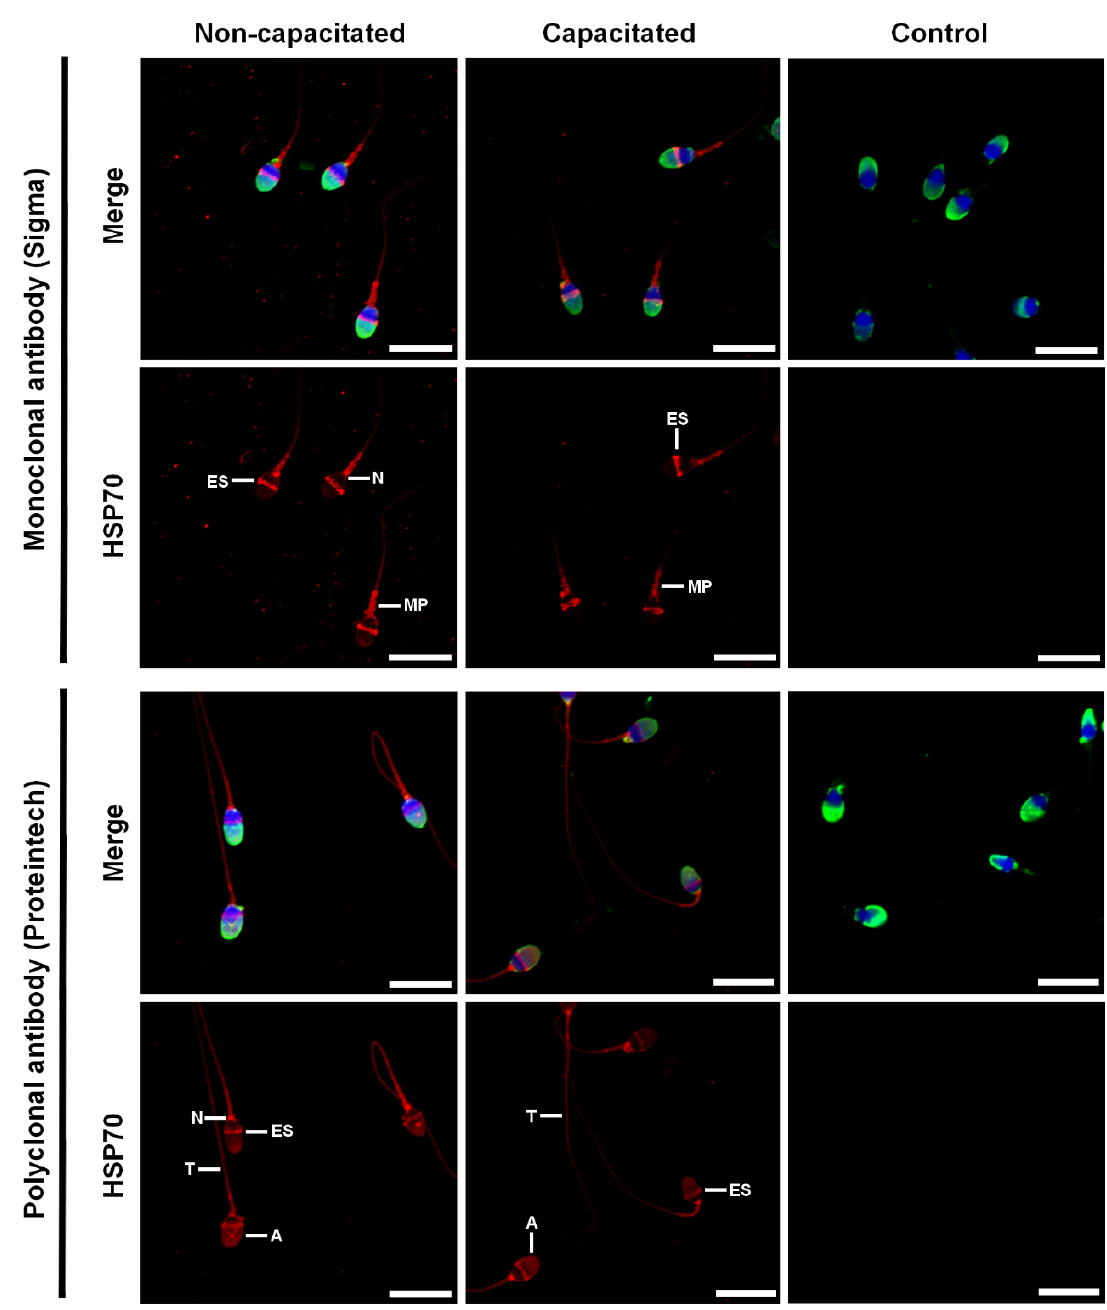
Figure 2. Localization of HSP70 in fixed and permeabilized human spermatozoa. Purified human spermatozoa were incubated or not in a capacitating medium for 4 h. They were then fixed with 4% paraformaldehyde, permeabilized with 0.3% Triton-X-100 and stained with monoclonal (Sigma, H5147) or polyclonal (Proteintech, 10995-1-AP) anti-HSP70 antibodies. Negative controls were performed by incubating non-capacitated spermatozoa without primary antibodies. Red: Hsp70, Blue: DAPI staining of the nucleus, Green: PSA-FITC staining of the acrosome. Scale bar: 10 µ m. Images are maximum-intensity projections (MaxIP) obtained from z stack images using Nikon NIS Elements software. Representative results of N = 4 experiments. A: acrosome, ES: equatorial segment, MP: mid-piece, N: neck, and T: